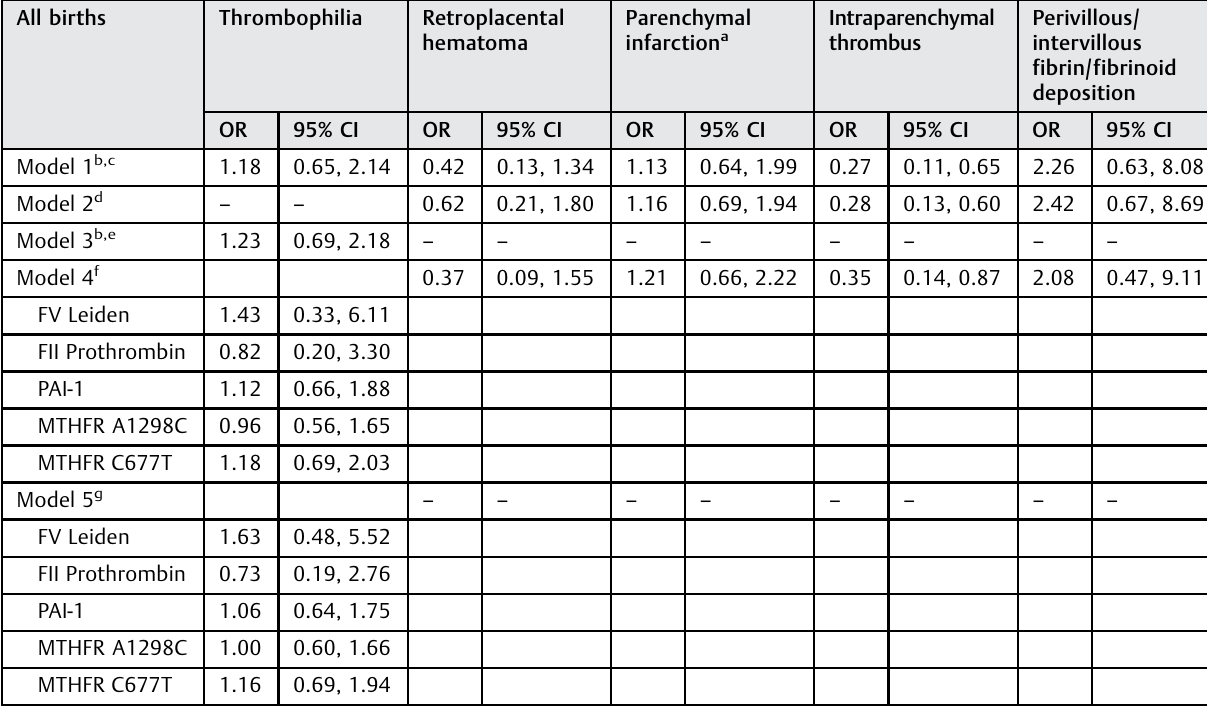
Table 7 Odds ratios for small for gestational age ( < 10th percentile) as a function of presence of maternal thrombophilia markers and placental characteristics related to maternal vascular malperfusion All